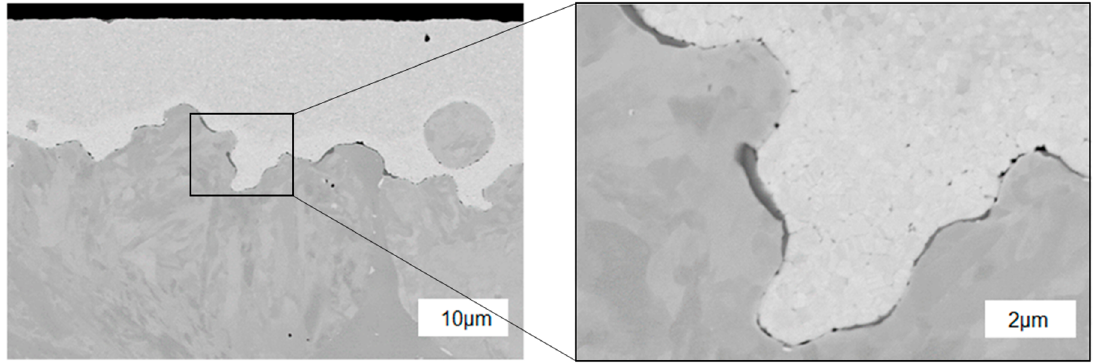
Figure 4. Interface of 17-4PH/YSZ laminate with phase formation after sintering.